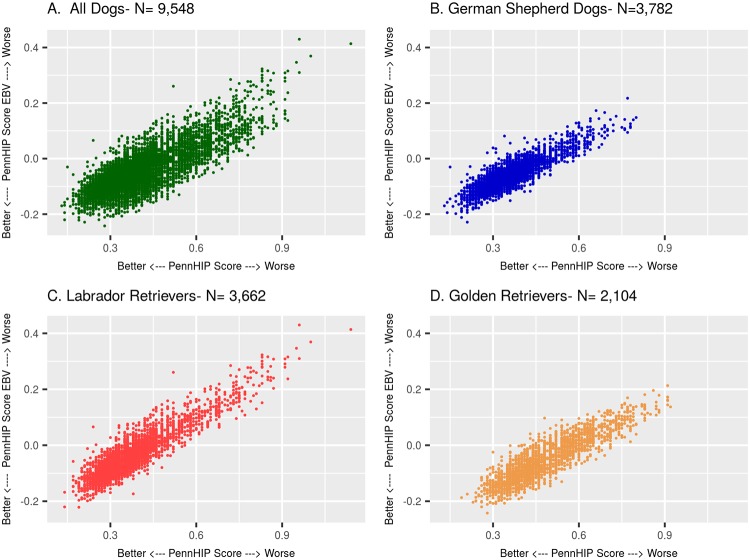
Scatterplot of estimated breeding values for PennHIP DI versus each dog’s own observed PennHIP DI value.All dogs in the study are shown in Panel A. Within breeds are shown in Panel B for GSD, C for LR, and D for GR.